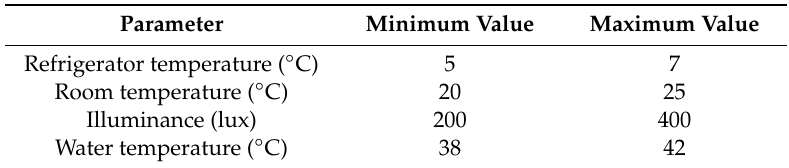
Table 3. User comfort